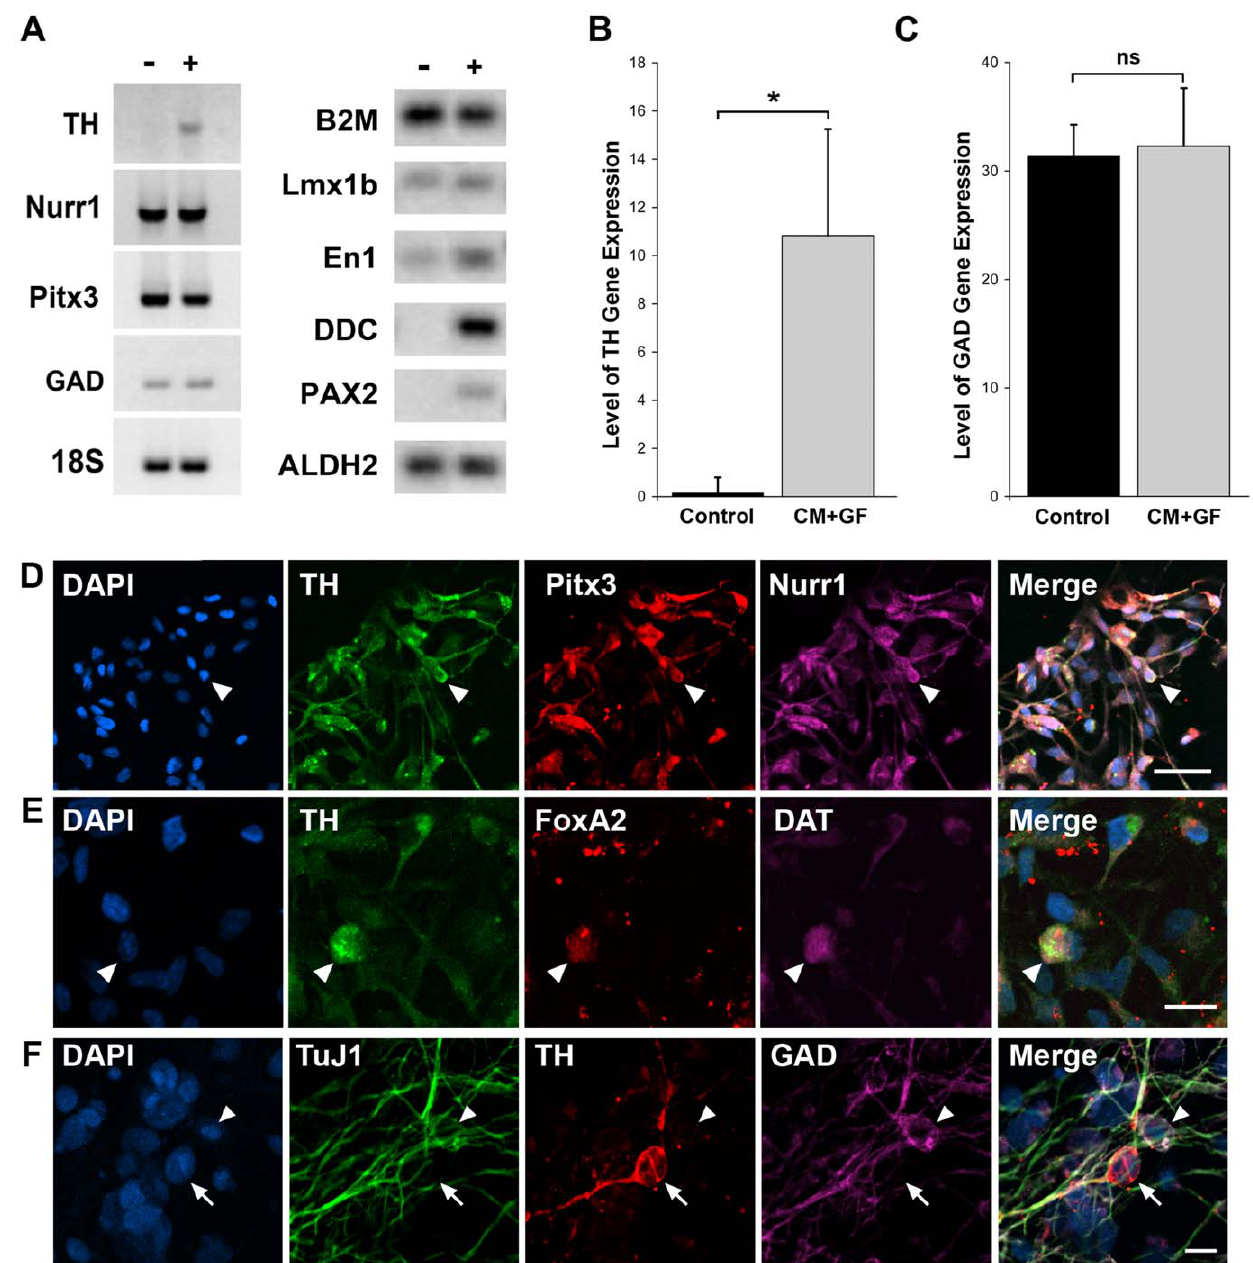
Figure 4. CM + GF stimulate TH and midbrain gene expression but not GAD. ( A ): Total RNA samples were extracted from hNSCs cultured for 10 days in the absence (line 2 ) or presence (line + ) of CM + bFGF + LIF. The relative abundance of TH, Nurr1, Pitx3, GAD and 18 S was assessed by RT- PCR (see Materials Methods section for the description of the primers used and the PCR conditions). CM + GF treated cultures (line + ) showed a selective increase in PAX2, En1, TH, and DDC transcripts. ( B, C ): Gel densitometry software (Image J) was used to quantify amplified PCR products in 3 independent experiments. TH mRNA was significantly increased in CM + GF treated culture in comparison to control (* p , 0.01), while GAD mRNA expression did not show significant differences between control and CM + GF treated cultures (ns = not significant). CM + GF treated cultures were immunostained for TH/Pitx3/Nurr1 ( D ) and TH/FoxA2/DAT (E). Photomicrographs in ( F ) show example of distinct cells expressing either the GABAergic maker GAD (purple, arrow head) or the DA marker TH (red, arrow). Scale bars are 50 m m (D), 20 m m (E), 10 m m